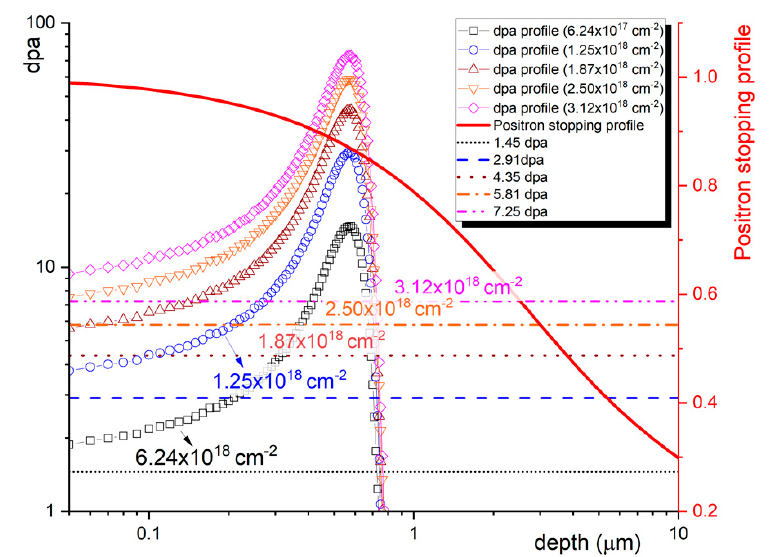
Figure 5. Displacement damage profiles obtained from SRIM simulation (Fe lattice; ‘quick Kinchin– Pease’ calculation option; lattice binding energy of 40 eV) and the apparent mean dpa values (corrected to the positron depth distribution function) for different helium fluencies.